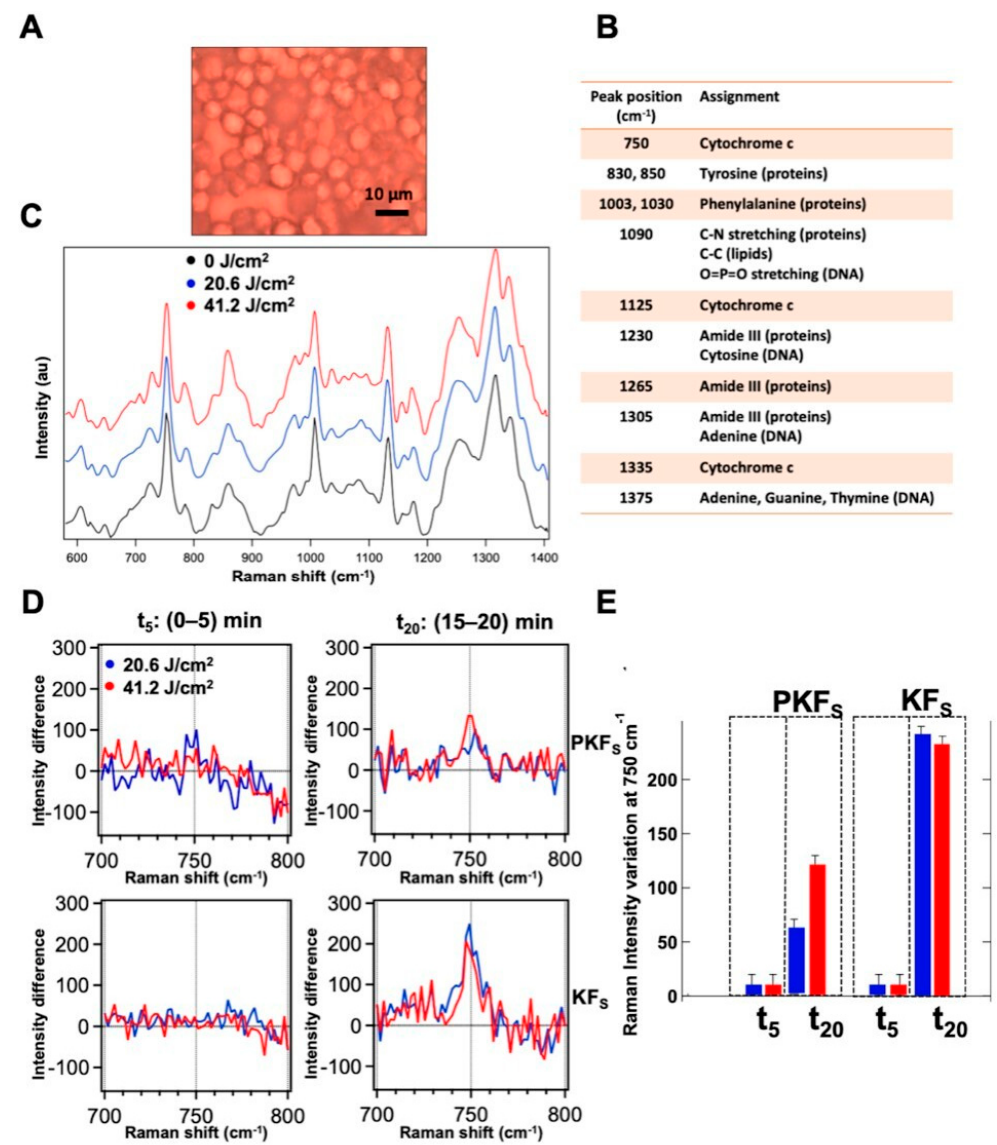
Figure 8. ( A ) Microscopic images of a typical keloid fibroblast pellet prepared for Raman measurements. ( B ) Main assignments of the Raman peaks in keloid fibroblast spectrum. ( C ) Averaged Raman spectra of keloid fibroblasts before (black) and after the application of 20.6 (blue) and 41.2 (red) J / cm 2 of blue LED light. ( D ) Di ff erential spectra obtained by subtraction of the pre-irradiation spectrum from the post-irradiation spectrum of perilesional and keloid cells averaged in the first 5 min (between 0 and 5 min after irradiation, t5) and in the last 5 min (between 15 and 20 min after irradiation, t20) of the Raman experiment. ( E ) Column bars showing the Raman intensity variation of the peak at 750 cm − 1 at di ff erent times after the irradiation at 20.6 J / cm 2 (blue) and 41.2 J / cm 2 (red) of blue LED light.